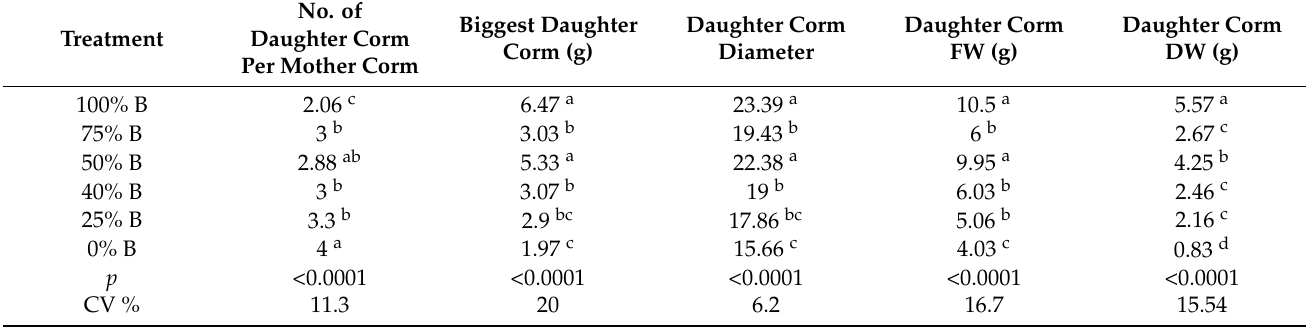
Table 4. Characteristics of saffron plants’ daughter corms grown under different ratios of Blue (B) to Red (R) light in the overall spectral composition, including 100% B, 75% B, 50% B, 40% B, 25% B, 0% B (see the spectrum in Figure 1), with 150 ± 10 µ mol m − 2 s − 1 PPFD. Means within a column followed by the same letters are not significantly different at p ≤ 0.01 according to Duncan’s multiple range test. CV % indicates the percentages of coefficient of variation among the treatments.